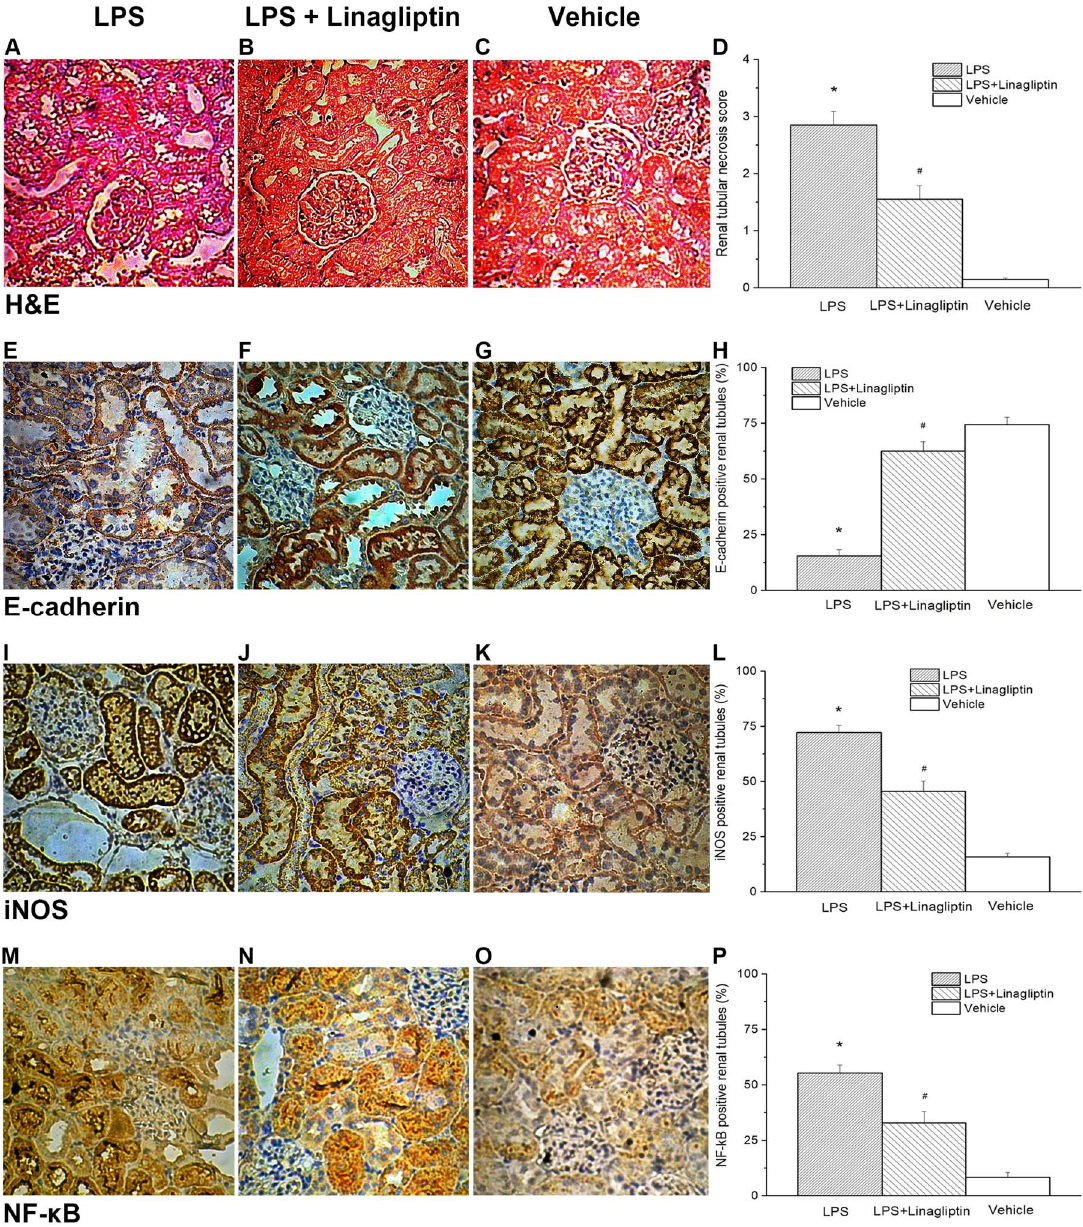
Figure 7. Post-treatment with linagliptin affected the histopathologic changes in the kidneys. Histologic sections stained with hematoxylin and eosin (magnification ×200) from the ( A ) LPS group, ( B ) LPS + Linagliptin group, and ( C ) Vehicle group. Renal tissue injury score after endotoxic-shock-induced acute renal failure in rats ( D ). Immunohistochemical staining for E-cadherin in kidneys (magnification ×200) from the ( E ) LPS group, ( F ) LPS + Linagliptin group, and ( G ) Vehicle group. E-cadherin-positive tubule score after endotoxic-shock-induced acute renal failure in rats ( H ). Immunohistochemical staining for iNOS in kidneys (magnification ×200) from the ( I ) LPS group, ( J ) LPS + Linagliptin group, and ( K ) Vehicle group. Inducible nitric oxide synthase (iNOS)-positive tubule score after endotoxic-shock-induced acute renal failure in rats ( L ). Immunohistochemical staining for NF-κB in kidneys (magnification ×200) from the ( M ) LPS group, ( N ) LPS + Linagliptin group, and ( O ) Vehicle group. NF-κB-positive tubule score after endotoxic-shock-induced acute kidney injury in rats ( P ). * p < 0.05 for the LPS group compared with the Vehicle group. # p < 0.05 for the LPS + Linagliptin group compared with the LPS group. Vehicle ( n = 8), LPS ( n = 4), and LPS + Linagliptin ( n = 6) groups at 48 h after LPS administration.